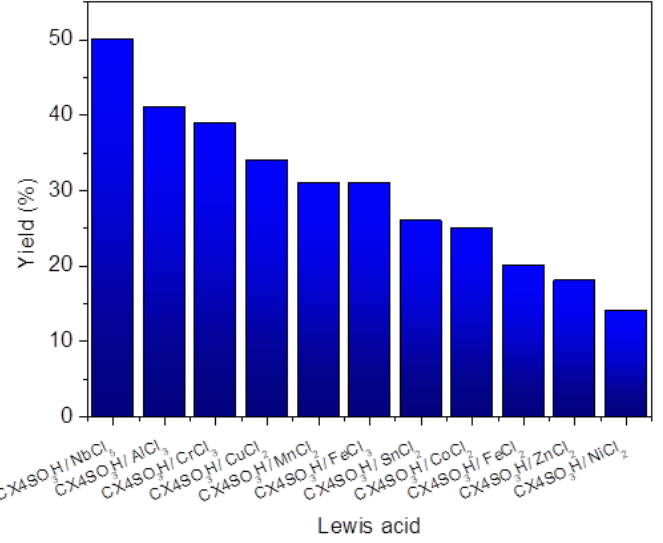
Figure 3. Evaluation of different Lewis acids. Reagents and conditions: 0.25 mmol glucose (45 mg), CX4SO 3 H/NbCl 5 (5/7.5 wt%), MW, 150 °C, 17.5 min, water/NaCl, and MIBK (1/3 v / v ).